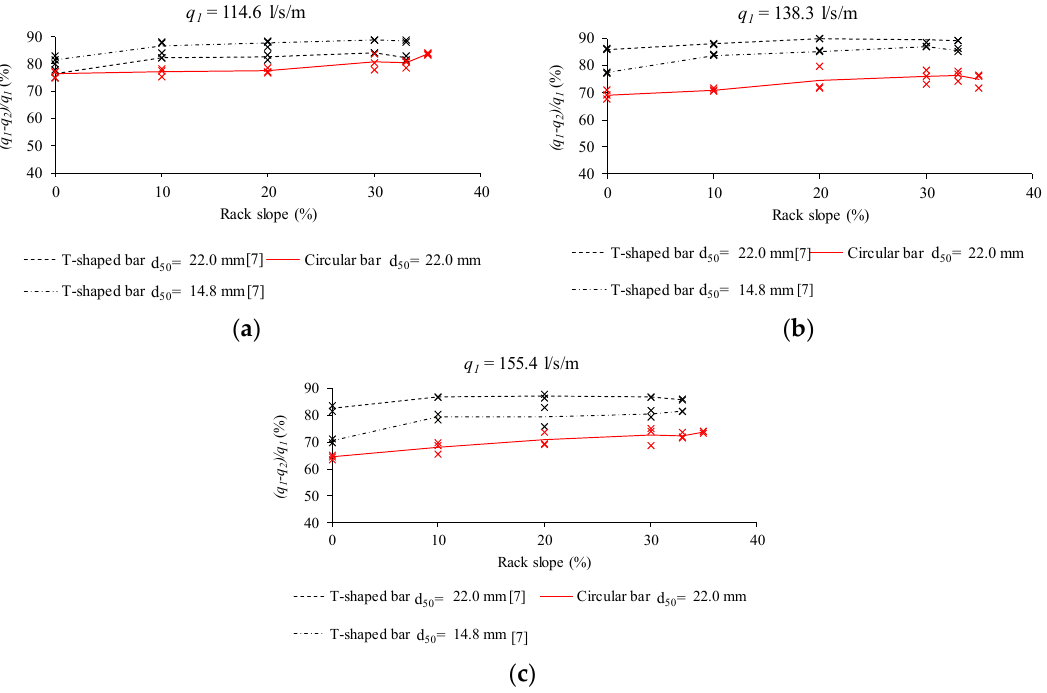
Figure 16. Comparison between percentage of derived flow for bottom racks with T-shaped bars (gravel 2 and gravel 3) and circular bars (gravel 3) for specific inlet flows: ( a ) 114.6 l/s/m; ( b ) 138.3 l/s/m; and ( c ) 155.5 l/s/m. Water 2018 , 10 , x FOR PEER REVIEW